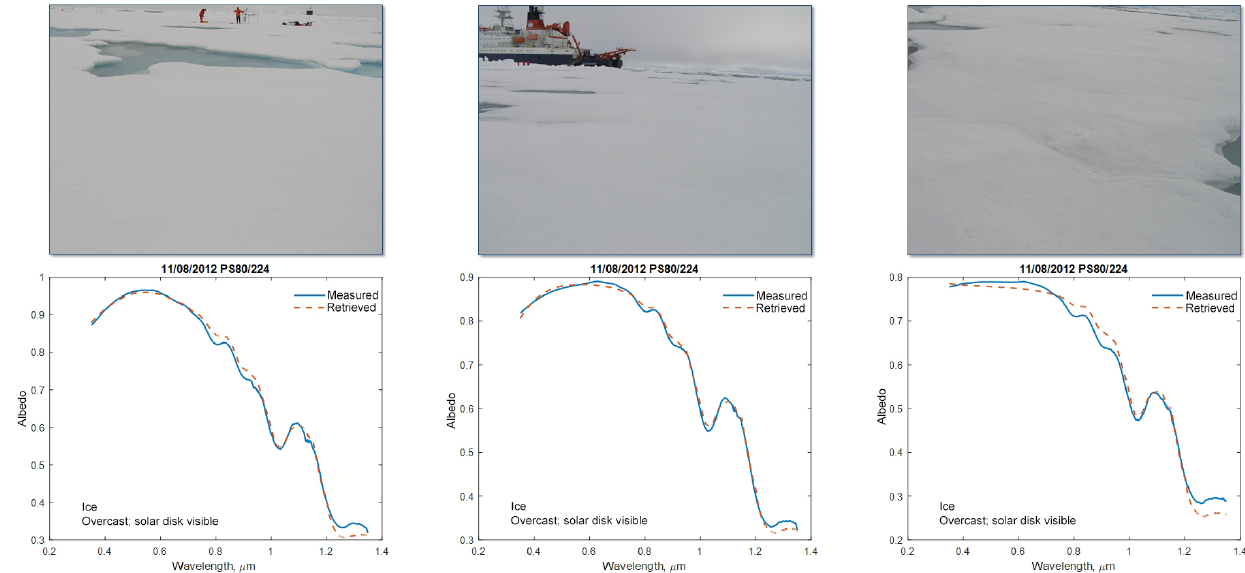
Figure 8. Bright white ice. The surface is dry; the scattering layer is 3–8cm thick; the average air temperature is − 1.2 ◦ C.